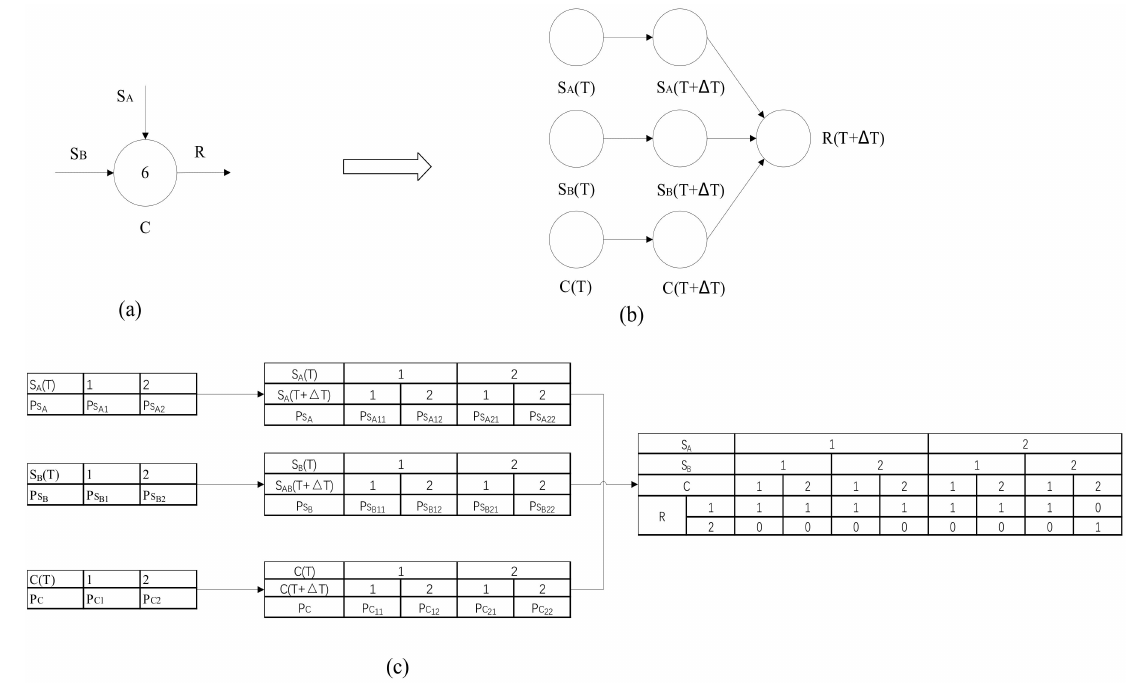
Figure 8. The dynamic Bayesian network corresponding to operator 6. ( a ) is the operator 6, ( b ) is the corresponding initial network and transition network, and ( c ) is the conditional probability table of each node.